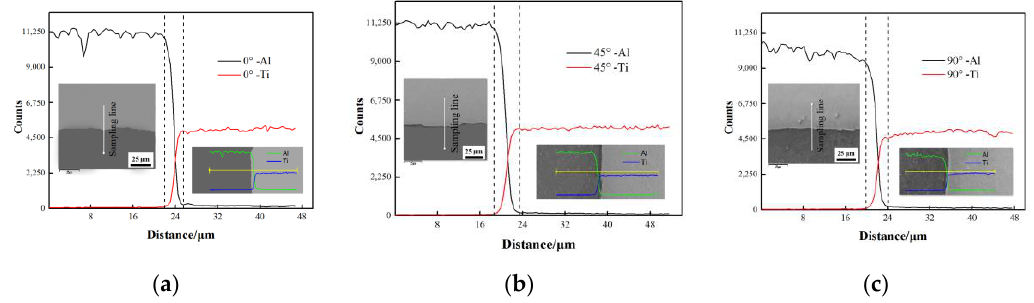
Figure 5. The back-scattered electron (BSE) image and micro-area element distribution across the interface of the Ti/Al laminated composites in ( a ) the 0° direction, ( b ) the 45° direction, ( c ) the 90° direction.